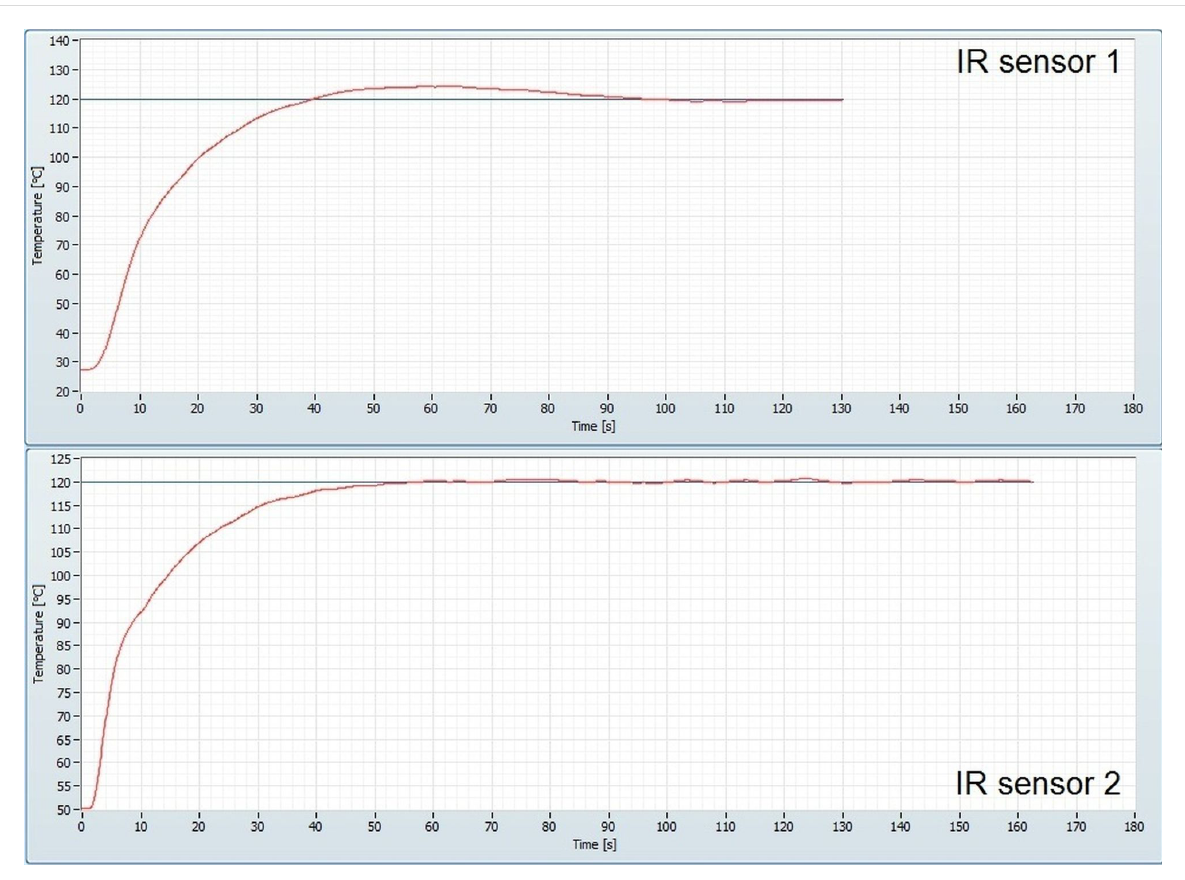
Figure 4: Heating profiles for IR sensor 1 (top) and IR sensor 2 (bottom) when heating isopropanol at a flow rate of 1 mL/min.